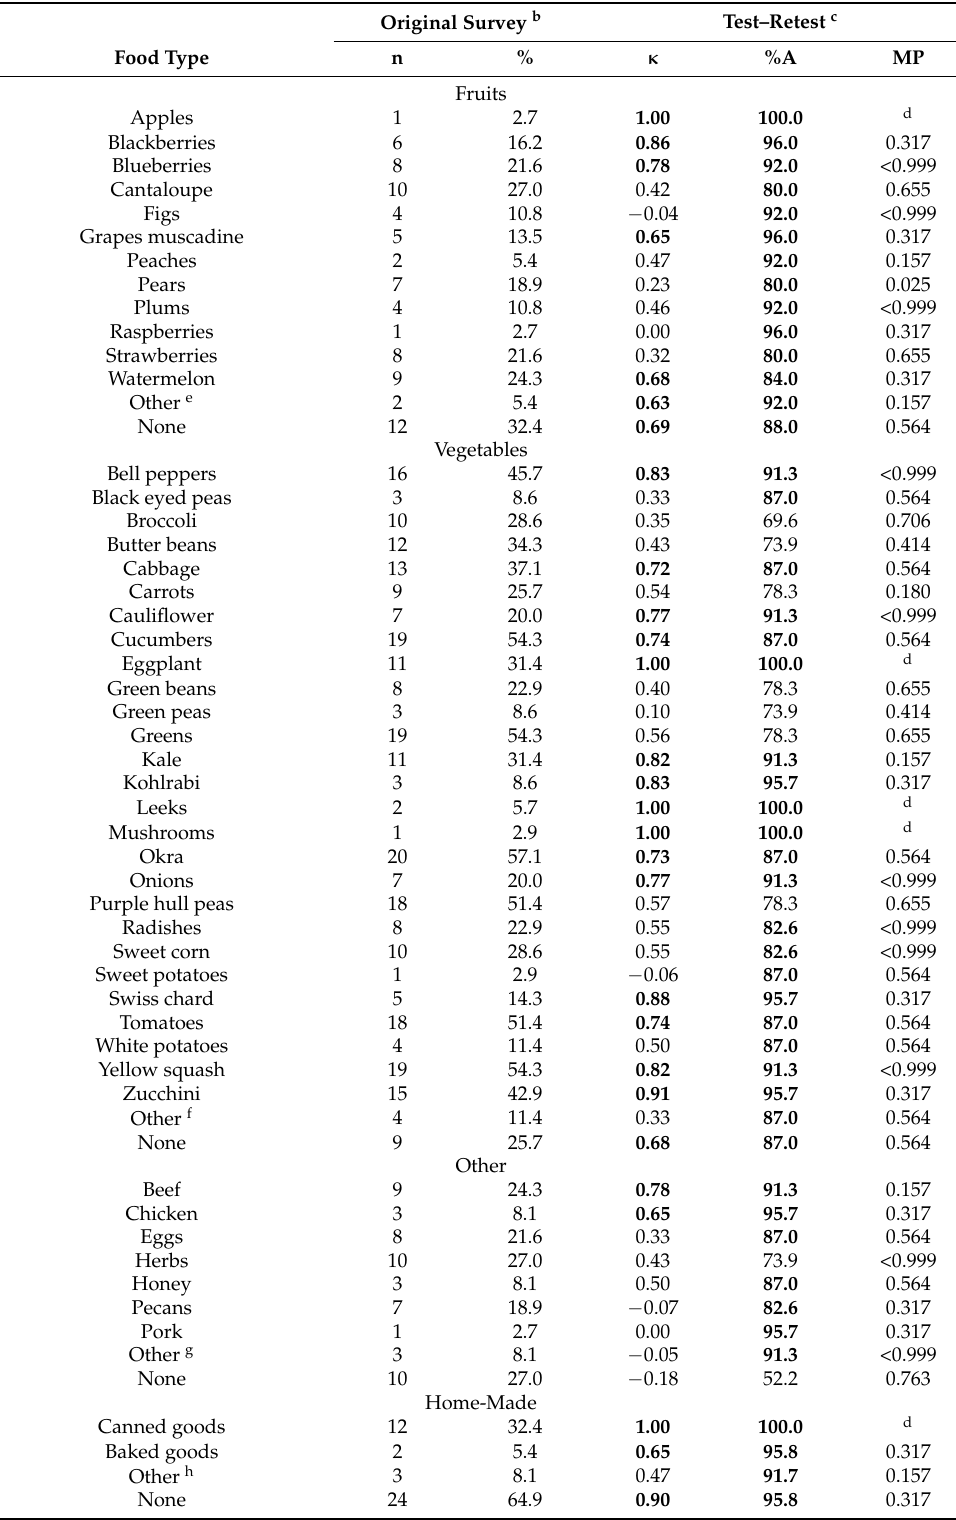
Table 2. Farm Products with Test–Retest Statistics a : Mississippi Farm to School Small Farmer Survey